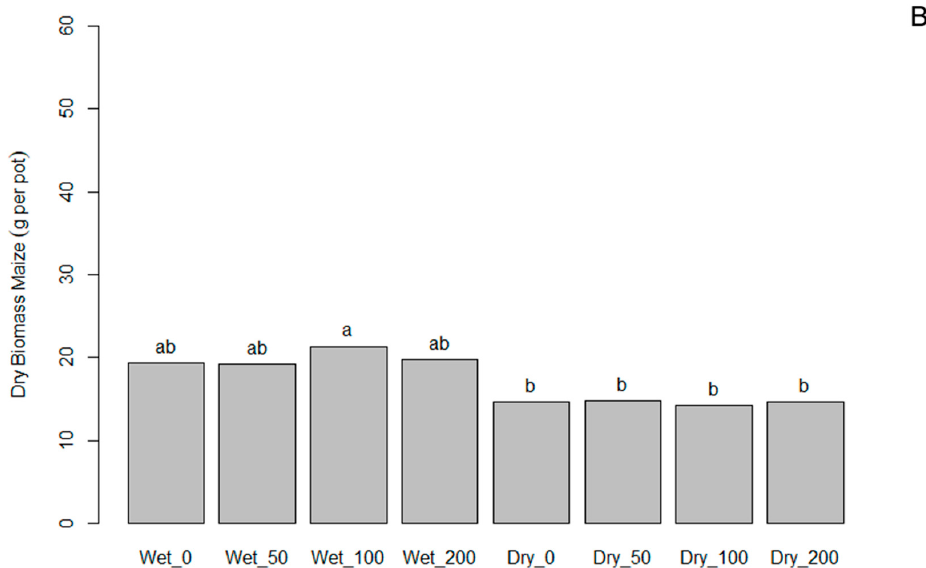
Figure 5. Maize biomass (g pot − 1 ) in response to drought stress and ComCat ® application at 50, 100, and 200 g ha − 1 at Hohenheim 2020, 47 days after sowing in the experiments ( A , B ). A rate of 100 g ha − 1 corresponds to the recommended field rate. Wet = 80% field capacity, Dry = 40% field capacity. Means with identical letters above the columns do not differ significantly based on Tukey’s HSD test ( p ≤ 0.05).